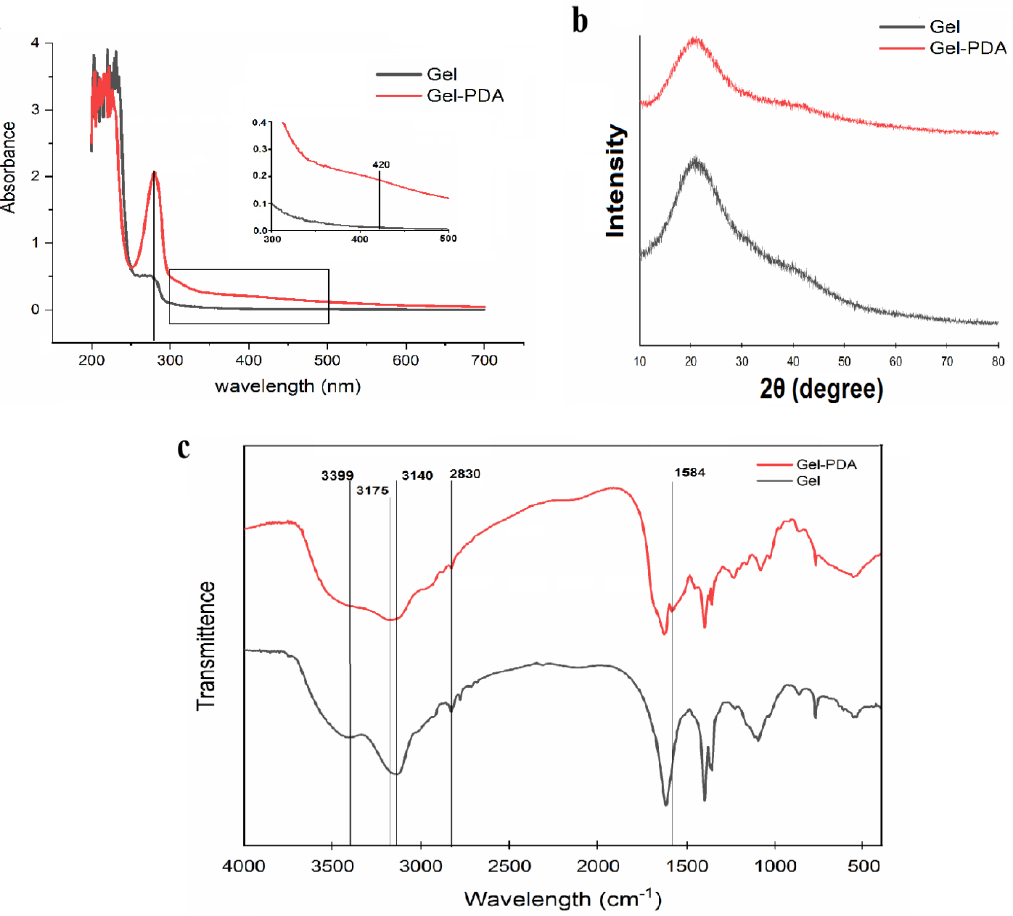
Figure 1. Characterization of dopamine polymerization on the gelatin chain. ( a ) UV − Vis spectrum of gel and Gel − PDA, ( b ) XRD analysis, ( c ) FT − IR spectrum.